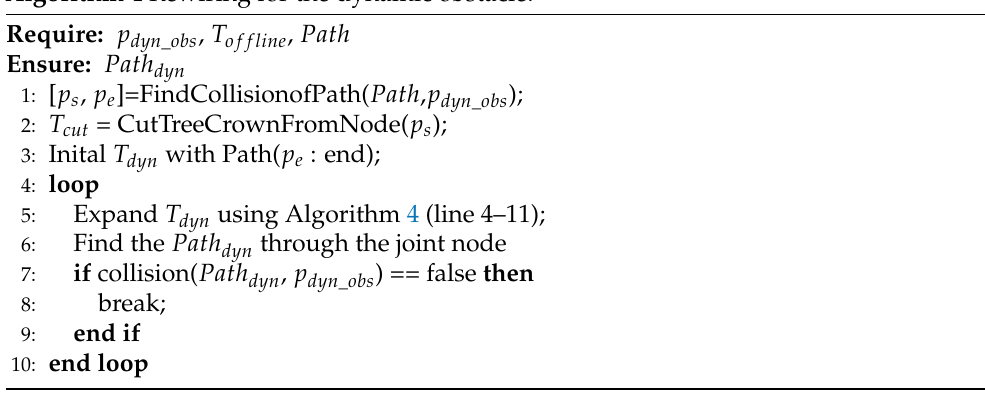
Algorithm 4 Rewiring for the dynamic obstacle.